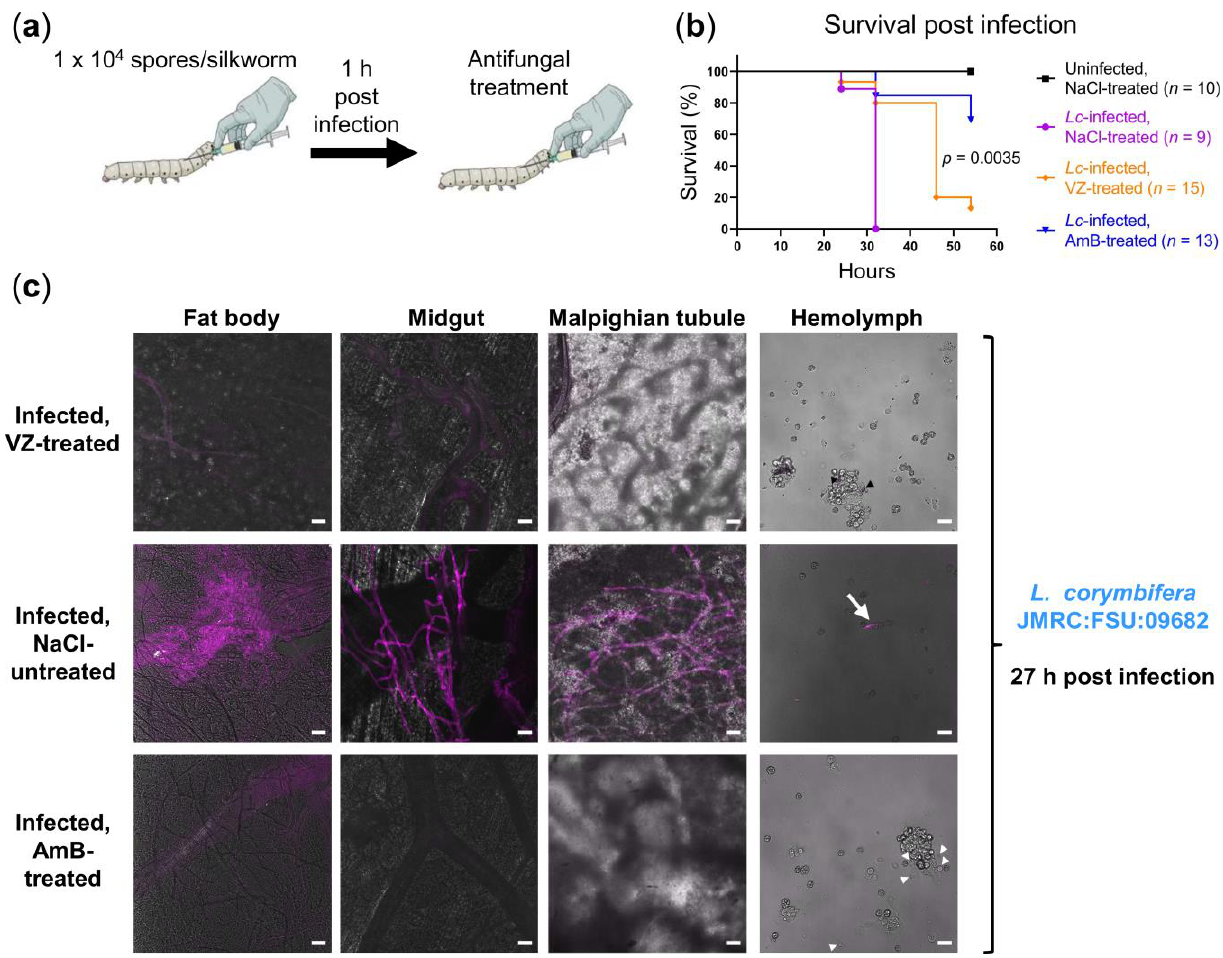
Figure 4. Therapeutic efficacy of voriconazole (VZ) and amphotericin B (AmB) in L. corymbifera -infected silkworms. ( a ) Illustration of experimental setup; ( b ) survival of L. corymbifera -infected silkworms with or without the antifungal treatment (10 µg voriconazole or amphotericin B at 1 h post infection); uninfected control was first injected with 50 µL NaCl-Tween; NaCl-treated controls received 20 µL 0.9% NaCl/10% DMSO following the first injection or infection; n: Number of silkworms in each group; Kaplan-Meier survival curves were compared using the log-rank test; pairwise comparison was performed between the VZ-treated and AmB-treated groups ( p = 0.0035); ( c ) merged images (calcofluor white in violet + brightfield) show fungal burden at 27 h post infection; to detect the fungus in hemolymph, calcofluor white pre-stained spores were used for infection; white arrowheads, black arrowheads, and white arrow indicate spores, germinated spores, and long hypha in the hemolymph, respectively; hyphae/mycelia were only visible in the organs of the infected, NaCl-treated control at the indicated time point; scale bars represent 20 µm.